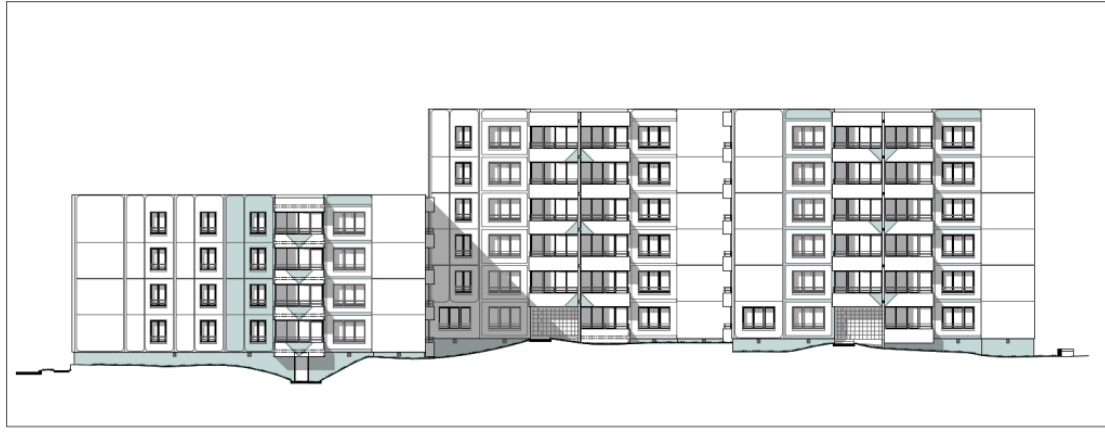
Figure 3. East side of the housing complex.